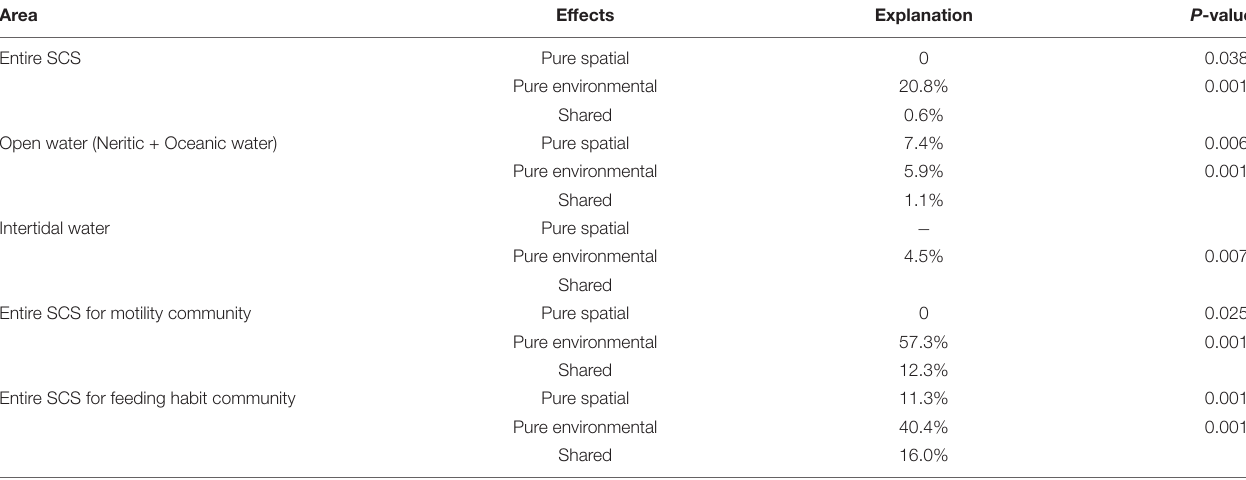
TABLE 2 | Effects of spatial and environmental variables on the ciliate communities in different areas of SCS analyzed by redundancy analysis (RDA).